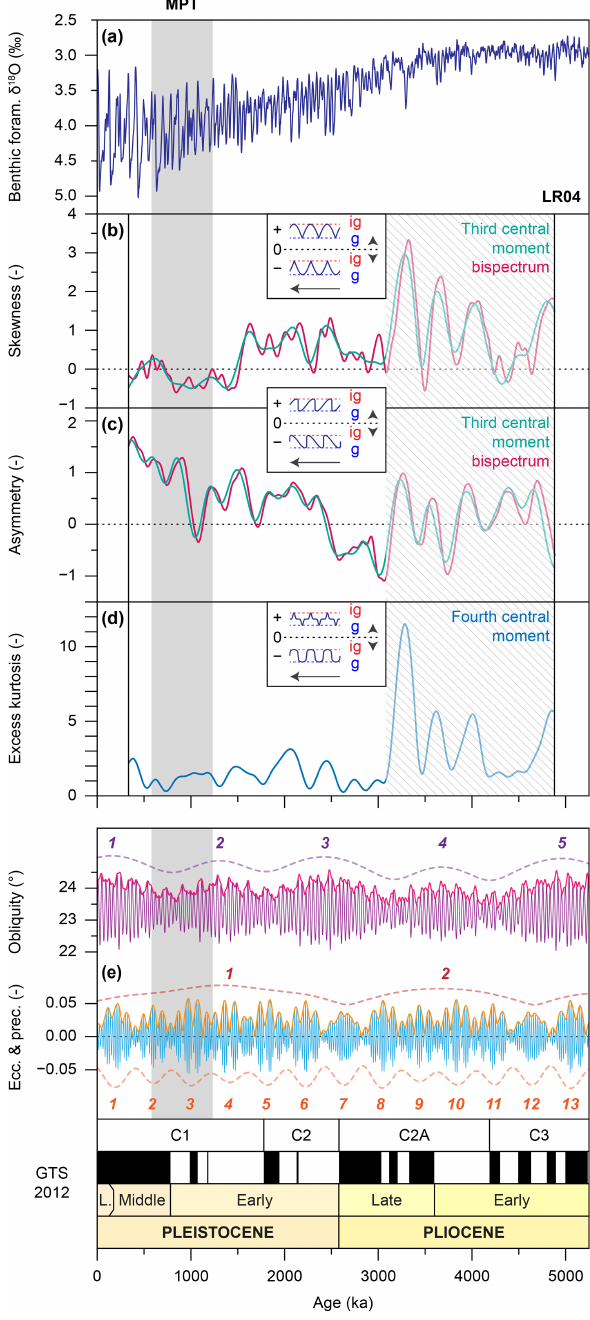
Figure 2. Non-sinusoidal properties of Pliocene and Pleistocene climate cycles (after Lisiecki and Raymo, 2007). (a) As in Fig. 1. (b) Evolution of glacial–interglacial cycle skewness, (c) asymme- try, and (d) excess kurtosis (i.e. normalised third and fourth central moments), computed over a 668kyr sliding window, using standard (teal and blue lines) and bispectral (pink lines) methods. Inset boxes show corresponding cycle shapes. The arrow shows the direction of time, “g” indicates glacial, and “ig” indicates interglacial. We focus the geometry interpretation on the time interval with the greater am- plitude variability in the record (transparent area). (e) As in Fig.